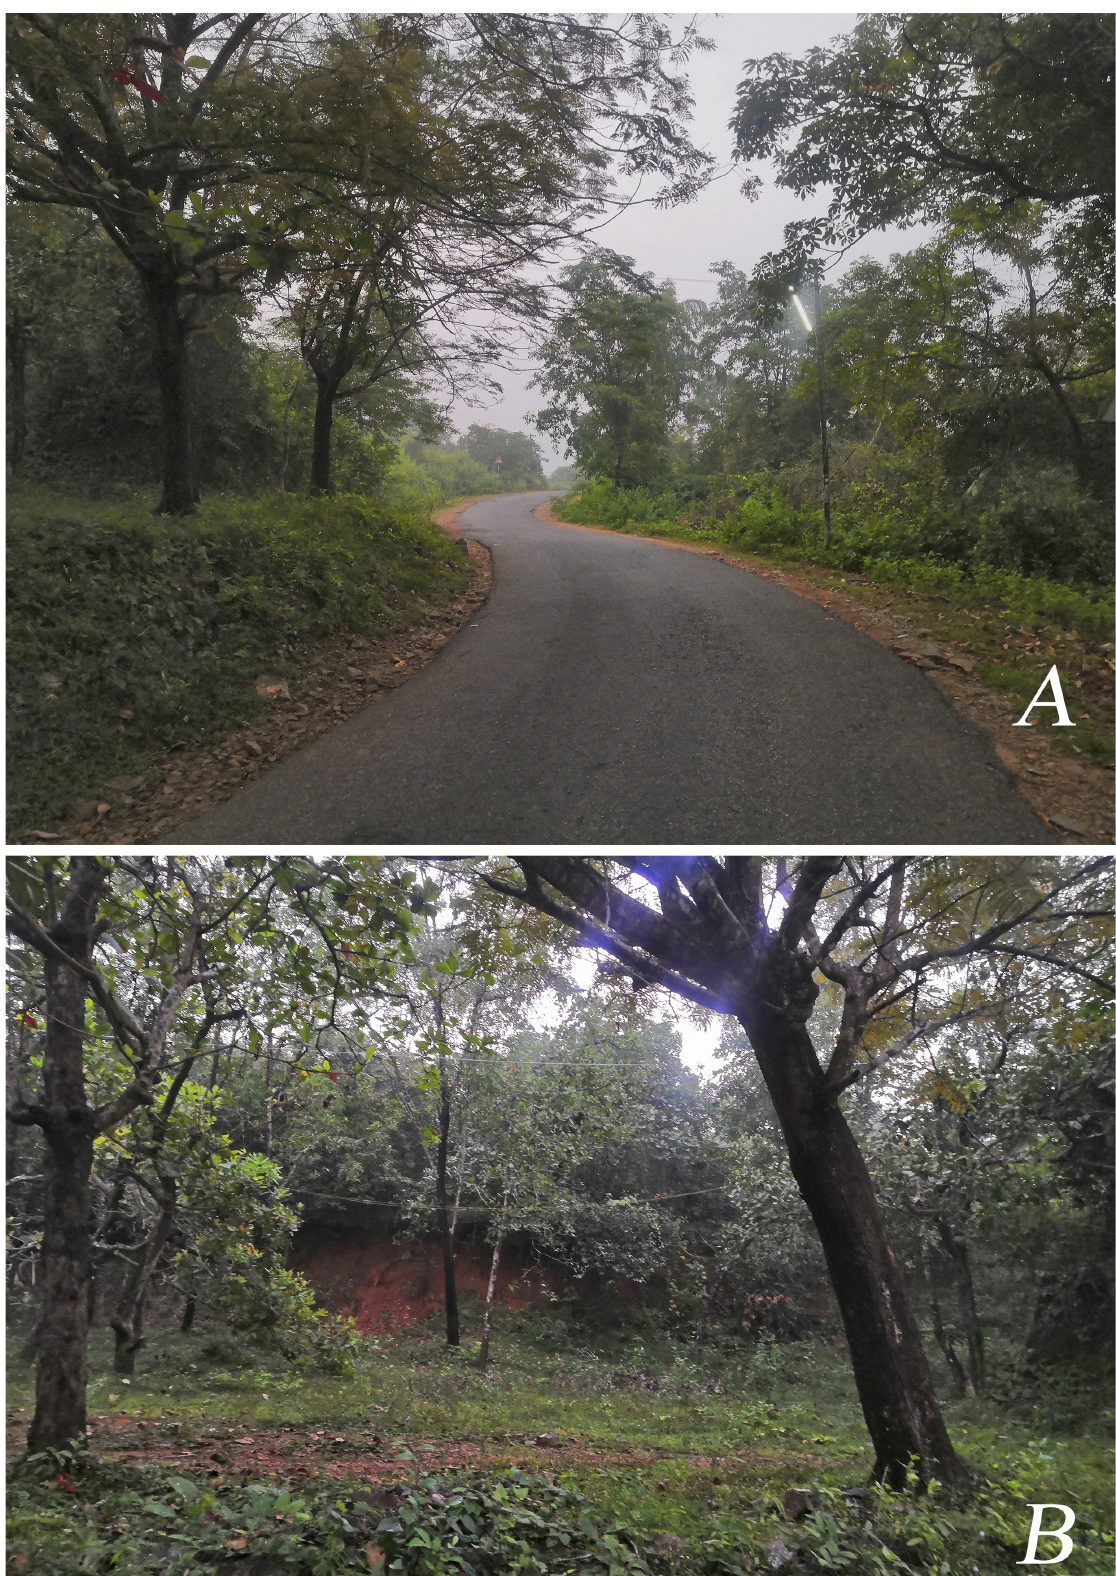
Fig. 7. Type locality of Isometrus sankeriensis Tikader & Bastawade, 1983. A . View of Sunkeri Road. B . View of semi-evergreen disturbed forest at the type